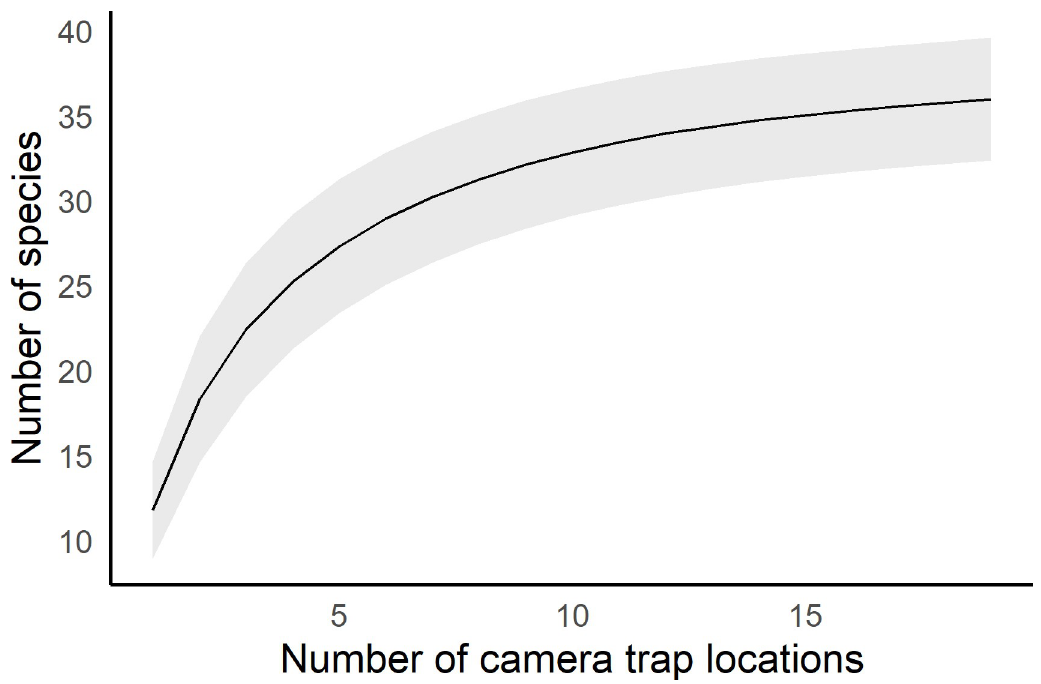
Fig 2. Landscape scale estimate of mammal species richness in Tli’ika, northern Tanzania. Species richness estimates are plotted against camera trap stations; the grey-shaded area indicates 95% confidence intervals of the mean.